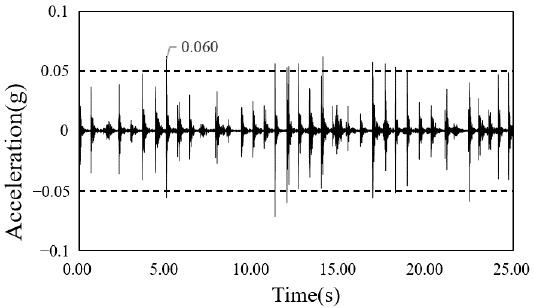
Figure 14. Time history of acceleration after framing completion (South-North church).